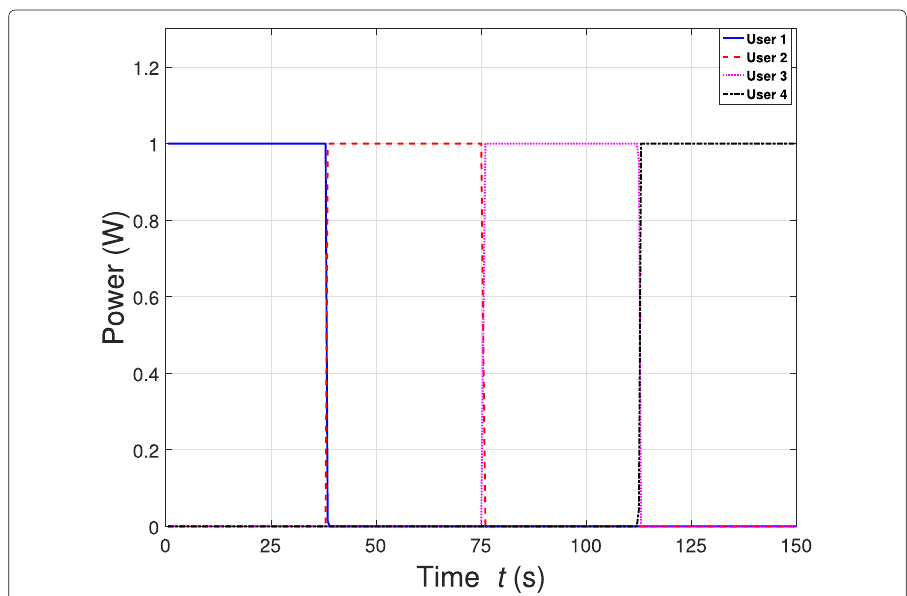
being served and allocates zero power to the other users. Figure 6 shows the rates of the users and the backhaul link versus time t . It can be seen that at any time t , the user being served has a positive rate, while the other users all have zero rates. Furthermore, it is observed that the rate of the backhaul link equals to the rate of the user being served at any time t ; this is because the proposed “B-P-T-OPT” scheme strikes a balance between the backhaul link and the access links so as to maximize the minimum user rate.